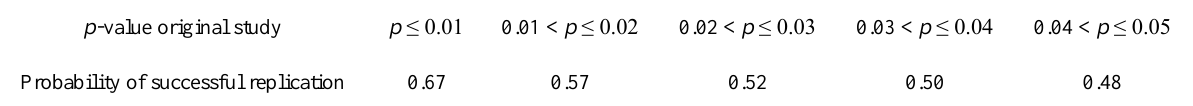
The Mathematically Derived Probability of a Successful Replication Attempt of an Original Study Randomly Selected from a Given Range of p-values from the 15,471 "Published" Simulation Studies. p -value original study p ≤